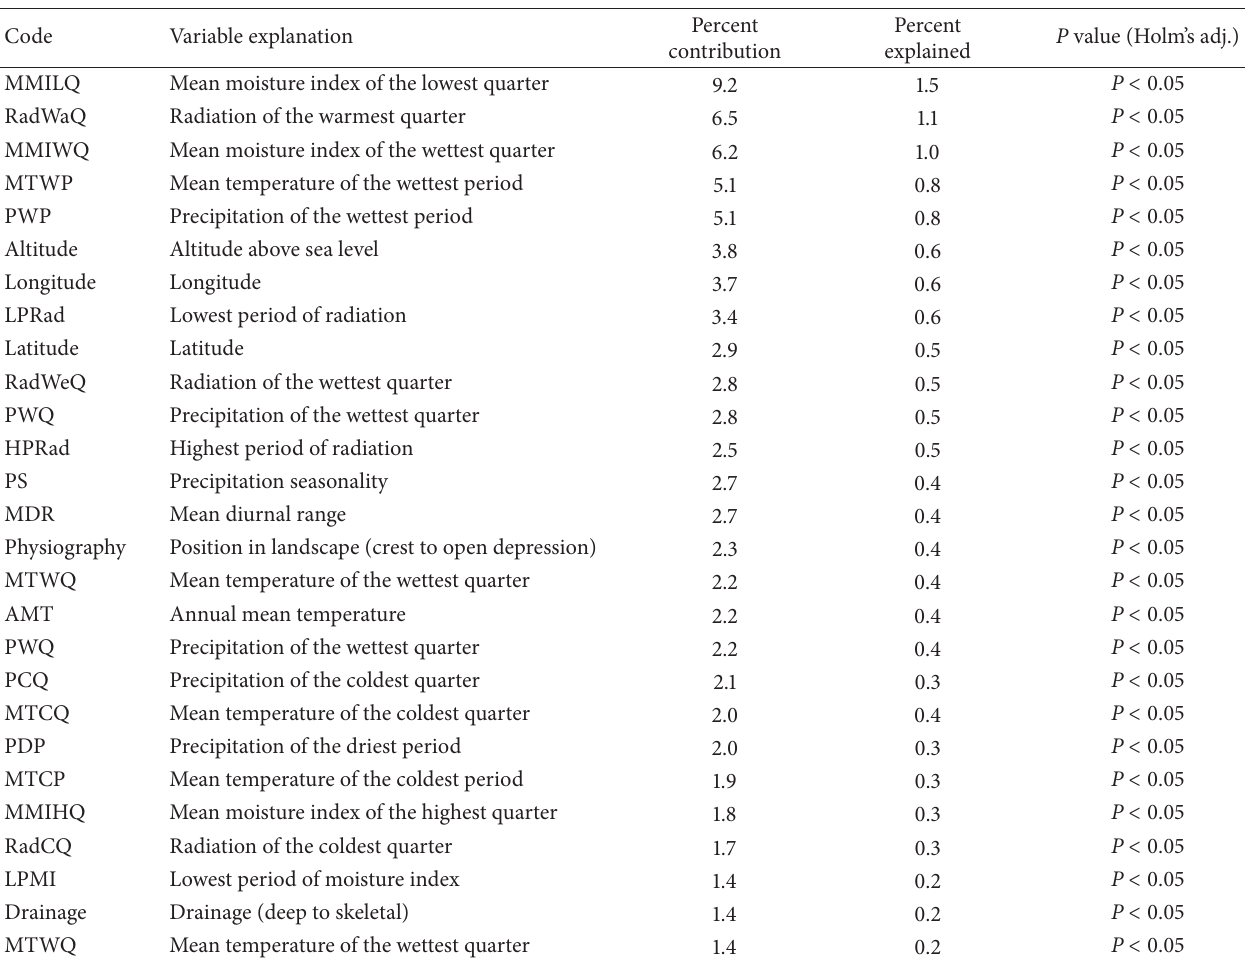
Table 3: Codes and descriptions of significant variables ( P ≤ 5%) listed in order of decreasing importance (contribution) from forward selection in plot/hollow biplot